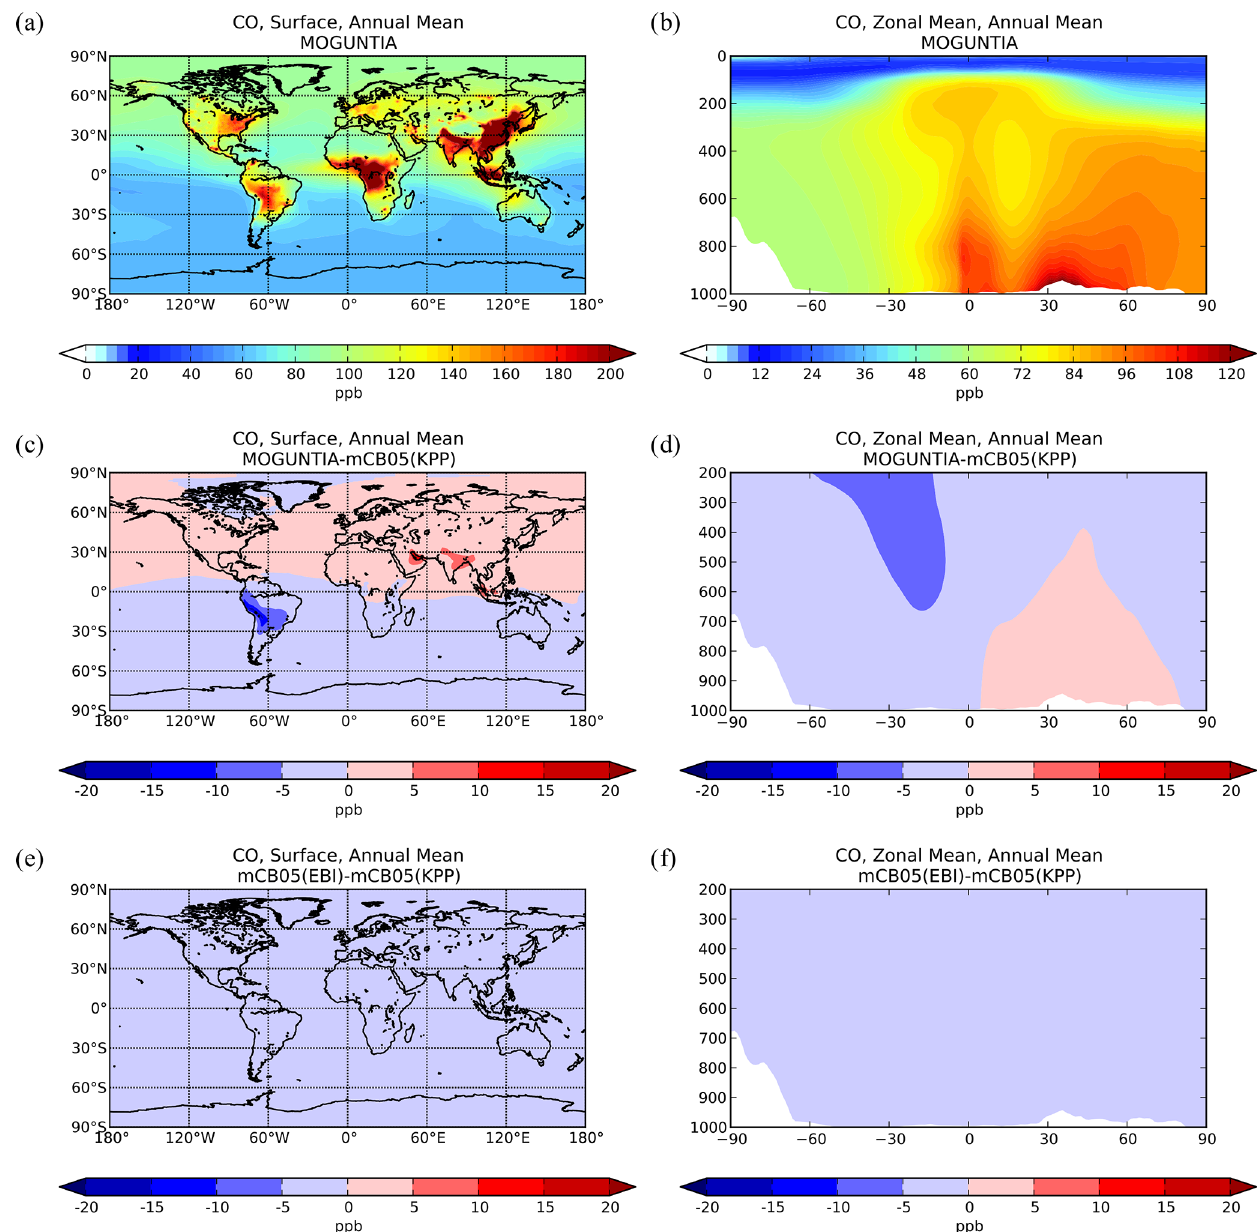
Figure 2. Simulated annual mean surface (a, c, e) and zonal mean (b, d, f) CO mixing ratios (ppb) for the MOGUNTIA chemistry scheme for the year 2006 (a, b) and the respective differences compared to mCB05(KPP) (c, d) ; the surface and zonal mean absolute differences between mCB05(KPP) and mCB05(EBI) are also presented (e, f)